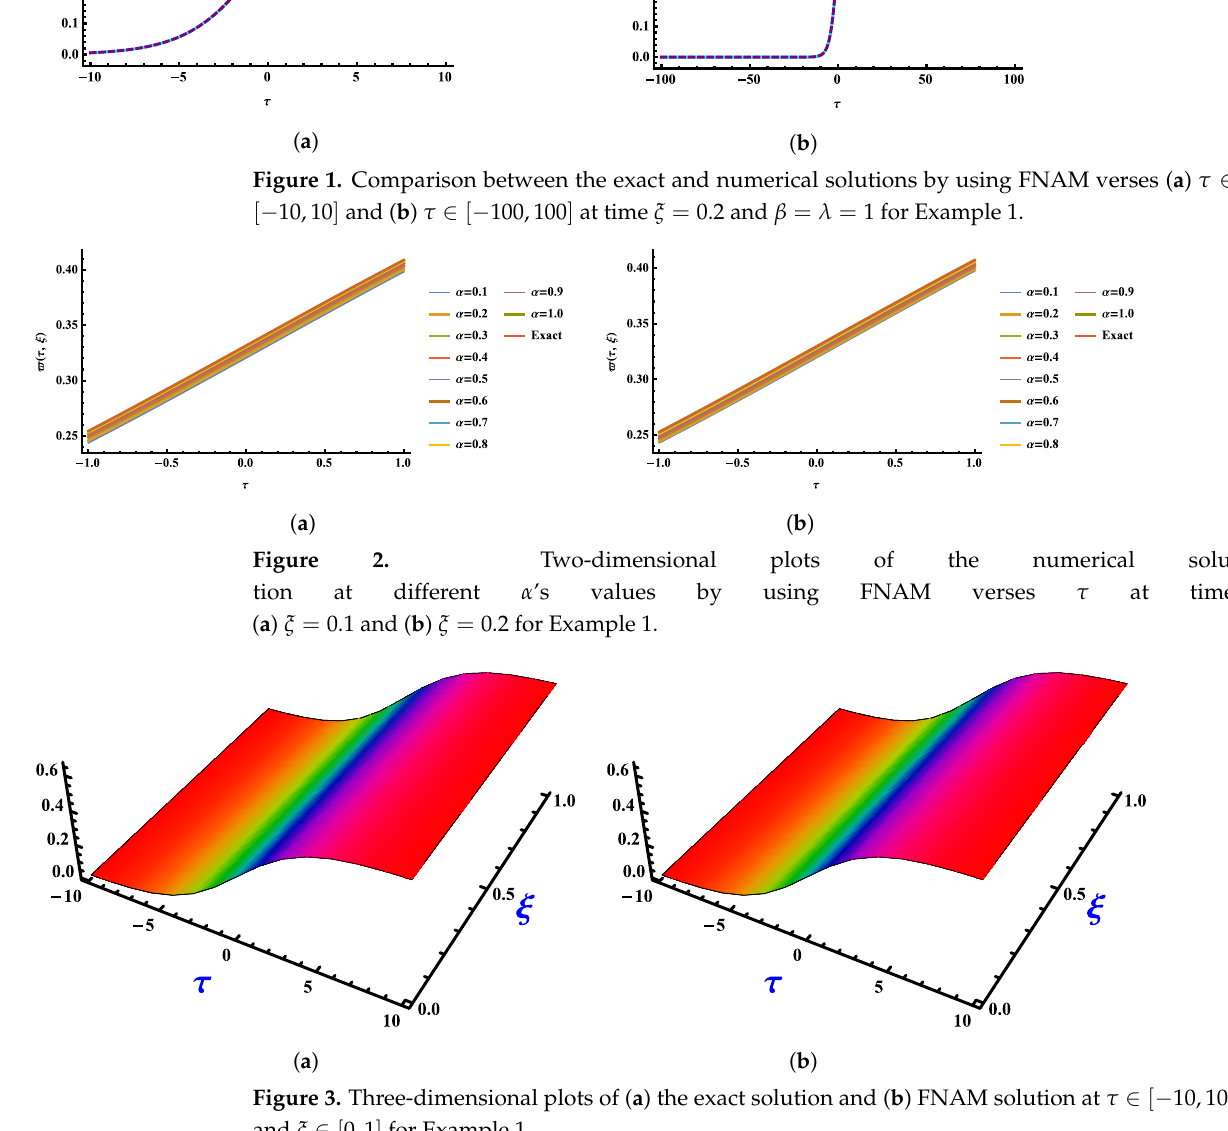
Figure 3. Three-dimensional plots of ( a ) the exact solution and ( b ) FNAM solution at τ ∈ [ − 10,10 ] and ξ ∈ [ 0,1 ] for Example